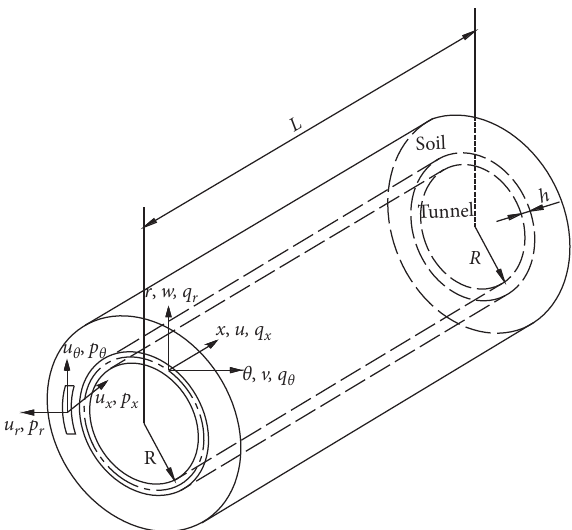
Figure 1: Geometric model of tunnel and